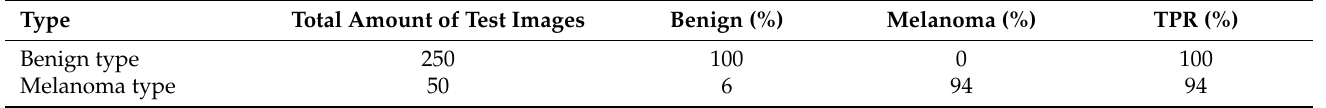
Table 4. ISIC 2016 dataset confusion